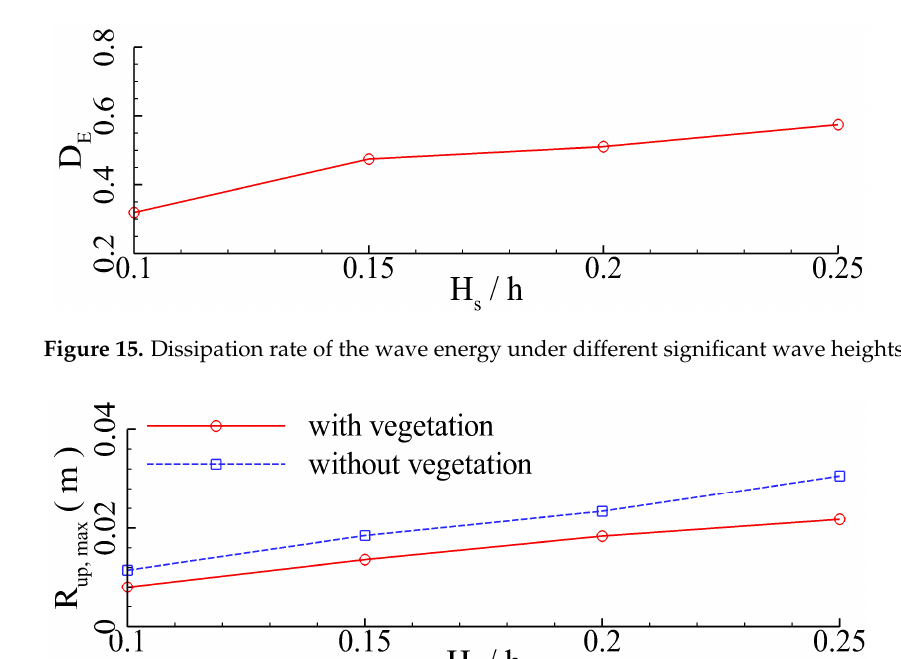
Figure 14. Decreasing rate of the local maximum wave height at the rear side of the vegetation patch under different significant wave heights.